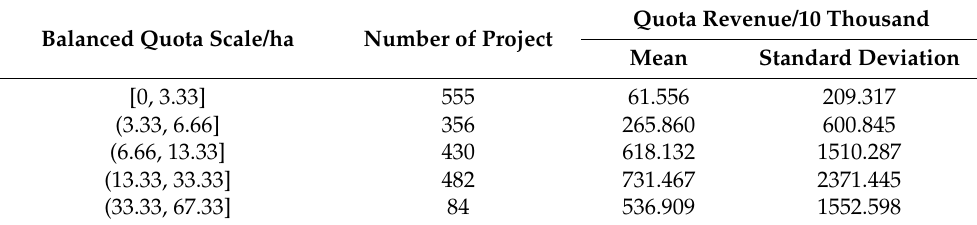
Table 2. Comparison of the scale and revenue of the balanced quota in different projects.